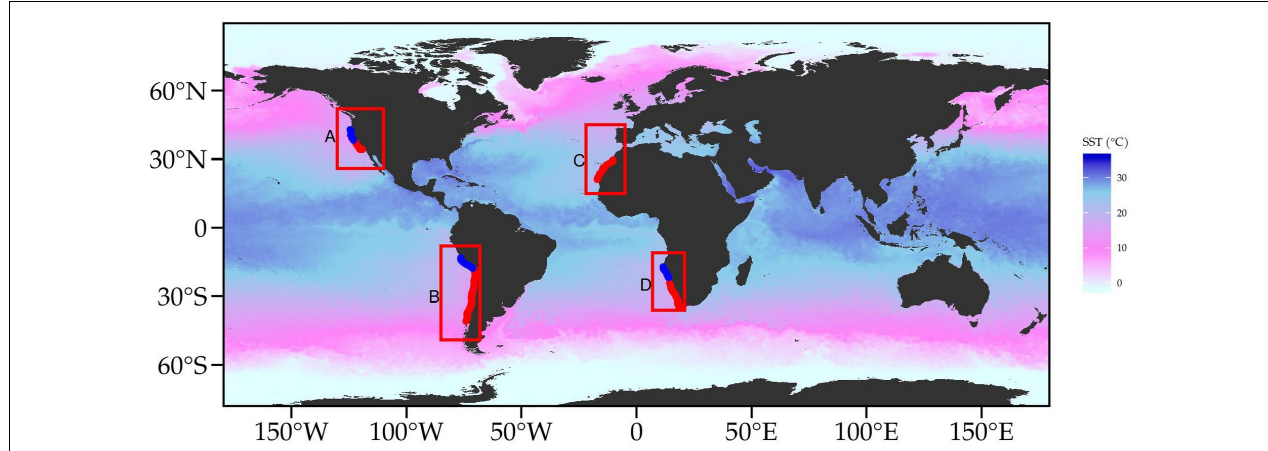
FIGURE 1 | OISST throughout the global ocean. The red colored rectangles delimit EBUS: (A) California (CCS), (B) Humboldt (HCS), (C) Canary (CnCS), and (D) Benguela (BCS) current systems. Two upwelling systems were analyzed along the Eastern Atlantic Ocean, these are the (A) Benguela (South 30.13–23.26 ◦ S; North 20.76–16.39 ◦ S) and Canary (18.89–32.63 ◦ N). Two upwelling systems were assessed in the Eastern Pacific Ocean, including the Humboldt Current (HCS: Chile 37.62–28.88 ◦ S, Peru 16.39–10.15 ◦ S) and California Current (CCS: South 33.88–36.06 ◦ N, North 37.94–42.31 ◦